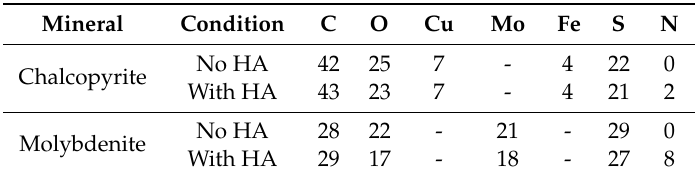
Table 3. Proportion (at.%) of the elements measured by X-ray photoeletron spectrometer (XPS) on the chalcopyrite and molybdenite surface without and with 20 mg/L humic acid (HA). Mineral Condition C O Cu Mo Fe S N No HA Chalcopyrite With HA 43 23 - 21 2 No HA 28 22 - 21 - Molybdenite With